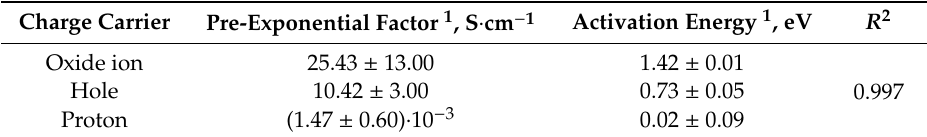
1038. As an example, the results obtained at log( p H 2 O /atm) = − 1.73 are shown in Figure 2. Figure 1. Rietveld refined XRD pattern of BZY10 sample slowly (~100 °C/h) cooled from 1500 °C to room temperature in dry air (log( p H 2 O/atm) = − 4.0): Observed X-ray diffraction intensity (points) and Table 1. Fitted parameters of Equation (4) calculated curve (line). The bottom curve is the difference of patterns, y obs -y cal , and the small bars indicate the angular positions of the allowed Bragg reflections